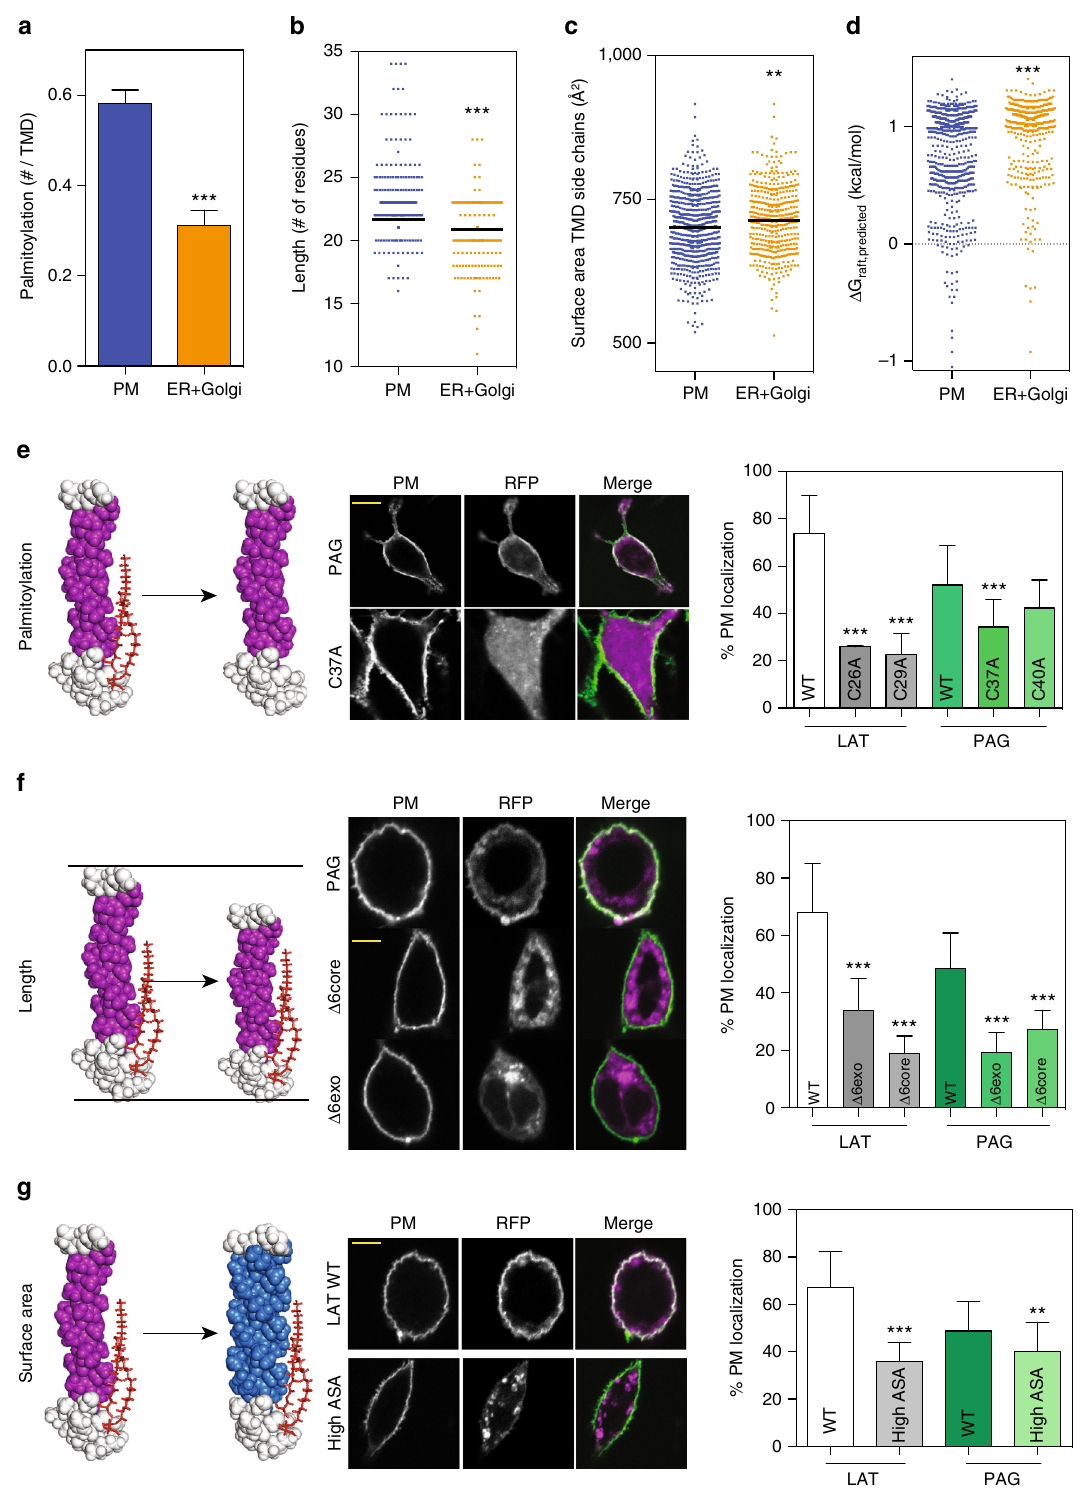
Fig. 4 PM proteins have higher raft partitioning, and mutations of raft af fi nity reduced PM localization. Proteome-wide bioinformatic predictions of a palmitoylation, b TMD length, and c TMD side chain surface area reveal that all features associated with raft partitioning are predicted to be signi fi cantly enhanced in single-pass PM proteins versus a combined set of single-pass ER and Golgi proteins. d Consistently, predicted raft af fi nity is signi fi cantly higher for PM proteins than non-raft (3 outliers omitted for clarity). Signi fi cances are one-way ANOVA relative to PM; *** p < 0.001; ** p < 0.01. The distribution of Δ G raft is clearly not unimodal; histogram with Gaussian fi ts in Supplementary Fig. 6. e – g Experimental evaluation of bioinformatics predictions. PM localization of two predicted raft proteins (LAT and PAG) was signi fi cantly reduced by mutating any of the structural features determining raft partitioning, including e palmitoylation, f TMD length, and g TMD surface area. Scale bars are 5 μ m. Avg ± SD for 20 – 40 cells/condition. Signi fi cances are one-way ANOVA relative to the wild-type TMD; *** p < 0.001; ** p <